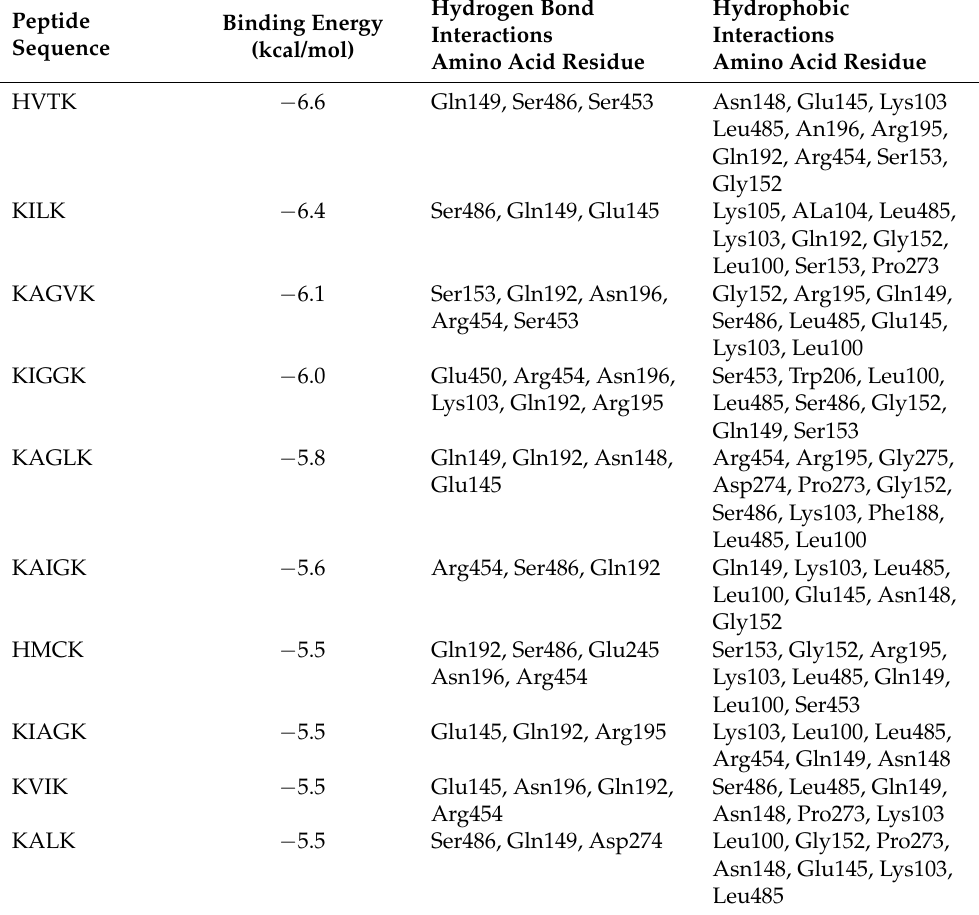
Table 7. Binding energy and interactions of potential active SCPs and standard molecule (1400 W) on NOS2 (PDB ID: